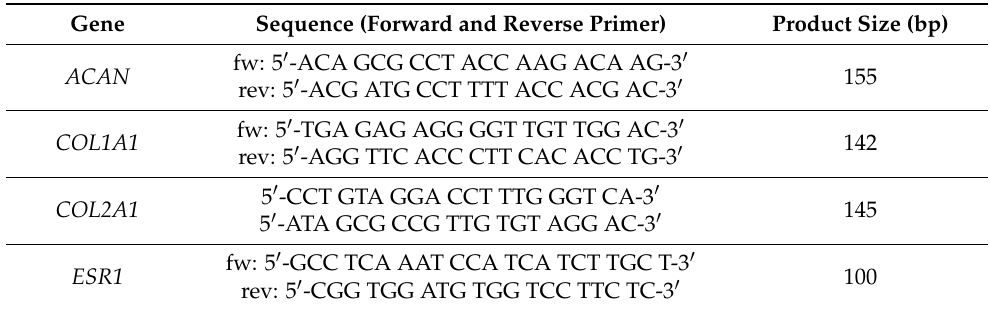
Table 1. Bovine oligonucleotide primers used for qRT-PCR. Primers with a shown sequence were custom designed; primers with an assay ID number were purchased from Applied